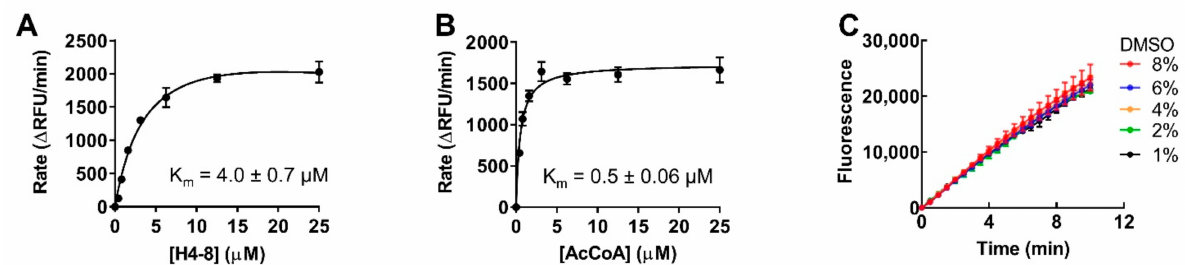
Figure 3. Steady-state kinetics of NatD activity. ( A ) Varied H4-8 concentration with AcCoA at 50 µ M. ( B ) Varied AcCoA concentration with H4-8 at 50 µ M. ( C ) The effect of % of DMSO on NatD activity.